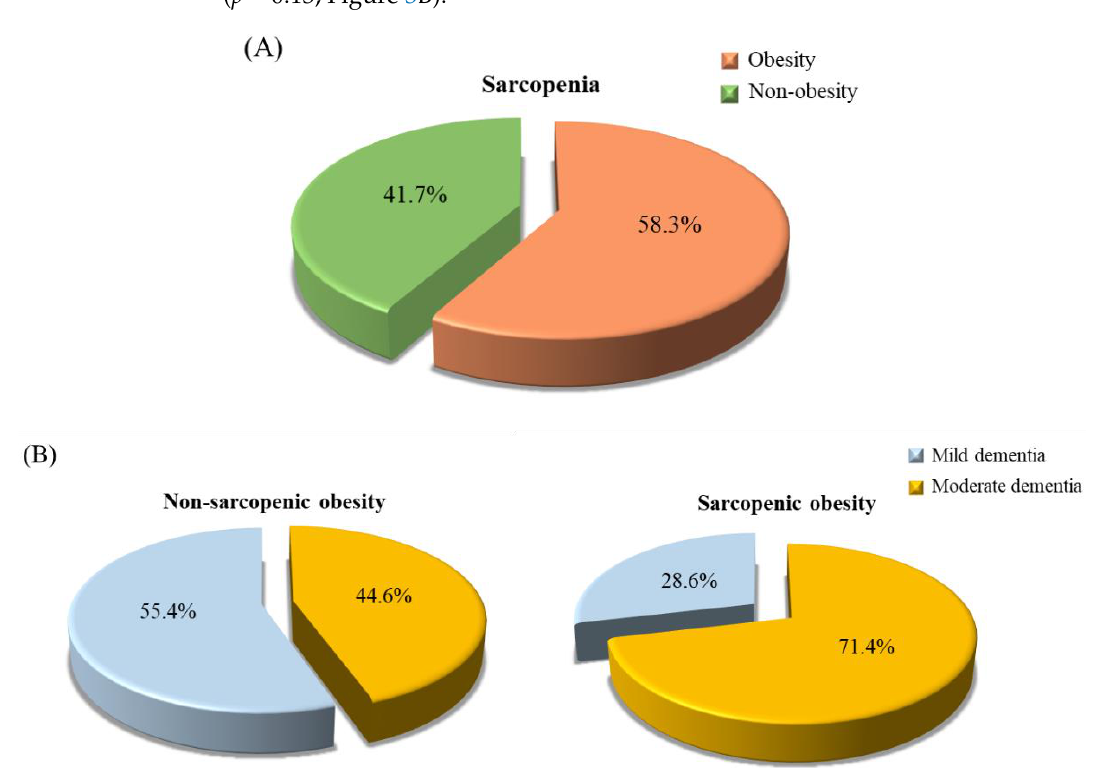
Figure 3. The proportion of sarcopenic obesity in patients with dementia. ( A ) The proportion of obesity in dementia patients with sarcopenia. Green is obesity dementia patients with sarcopenia; orange is non-obesity dementia patients with sarcopenia. ( B ) The proportion of dementia severity in patients with dementia stratified by sarcopenic obesity ( p = 0.13). Blue is mild dementia; yellow is moderate dementia.